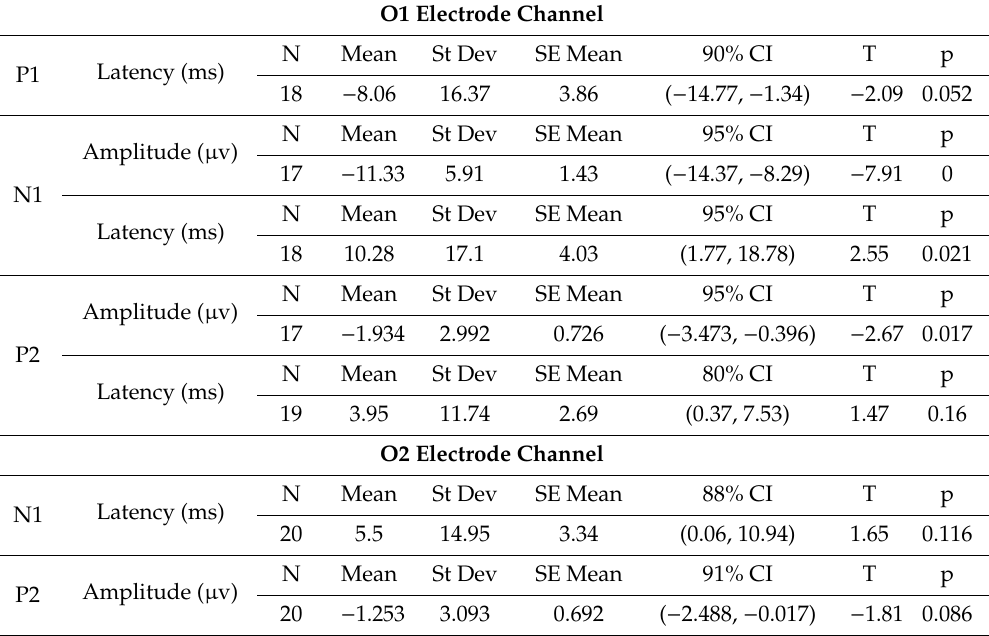
Table 4. Amplitude and latency di ff erences of N and P components of visual ERP waves evoked by Pattern